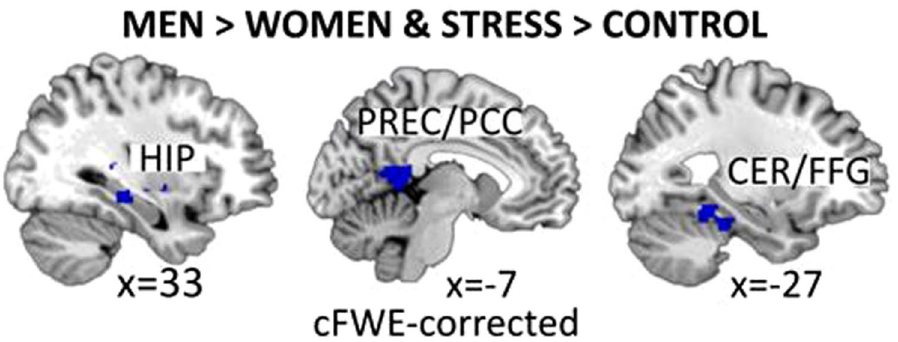
Figure 1. Sex-differences on whole-brain level: Higher activation in men than in women in the stress compared to the control condition. HIP = hippocampus; PREC/PCC = precuneus/posterior cingulate gyrus; CER/ FFG = cerebellum/fusiform